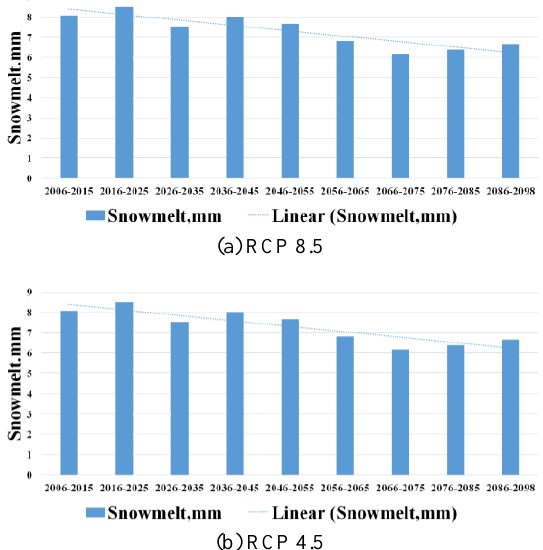
Figure 8. Change in snow depth under each scenario for Beas Basin